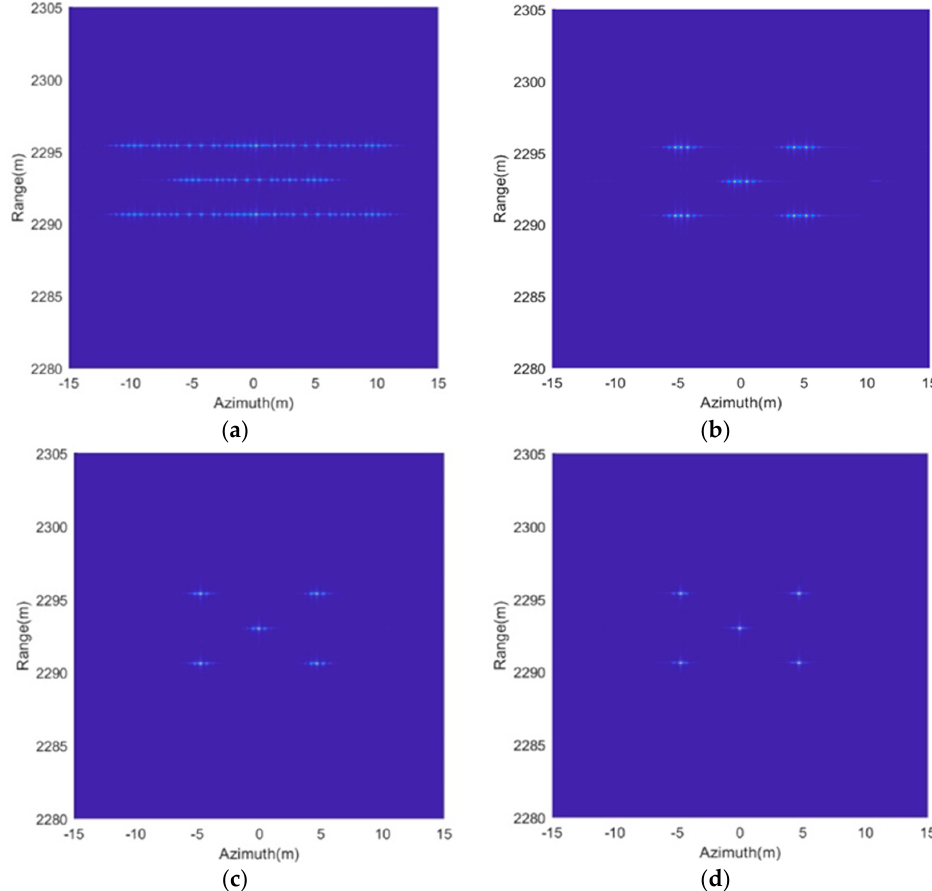
Figure 6. Comparison of compensation effect. ( a ) No compensation; ( b ) compensation based on STFT with h = 20; ( c ) compensation based on STFT with h op = 26; ( d ) compensation based on STFT with h op = 26 and RANSAC.